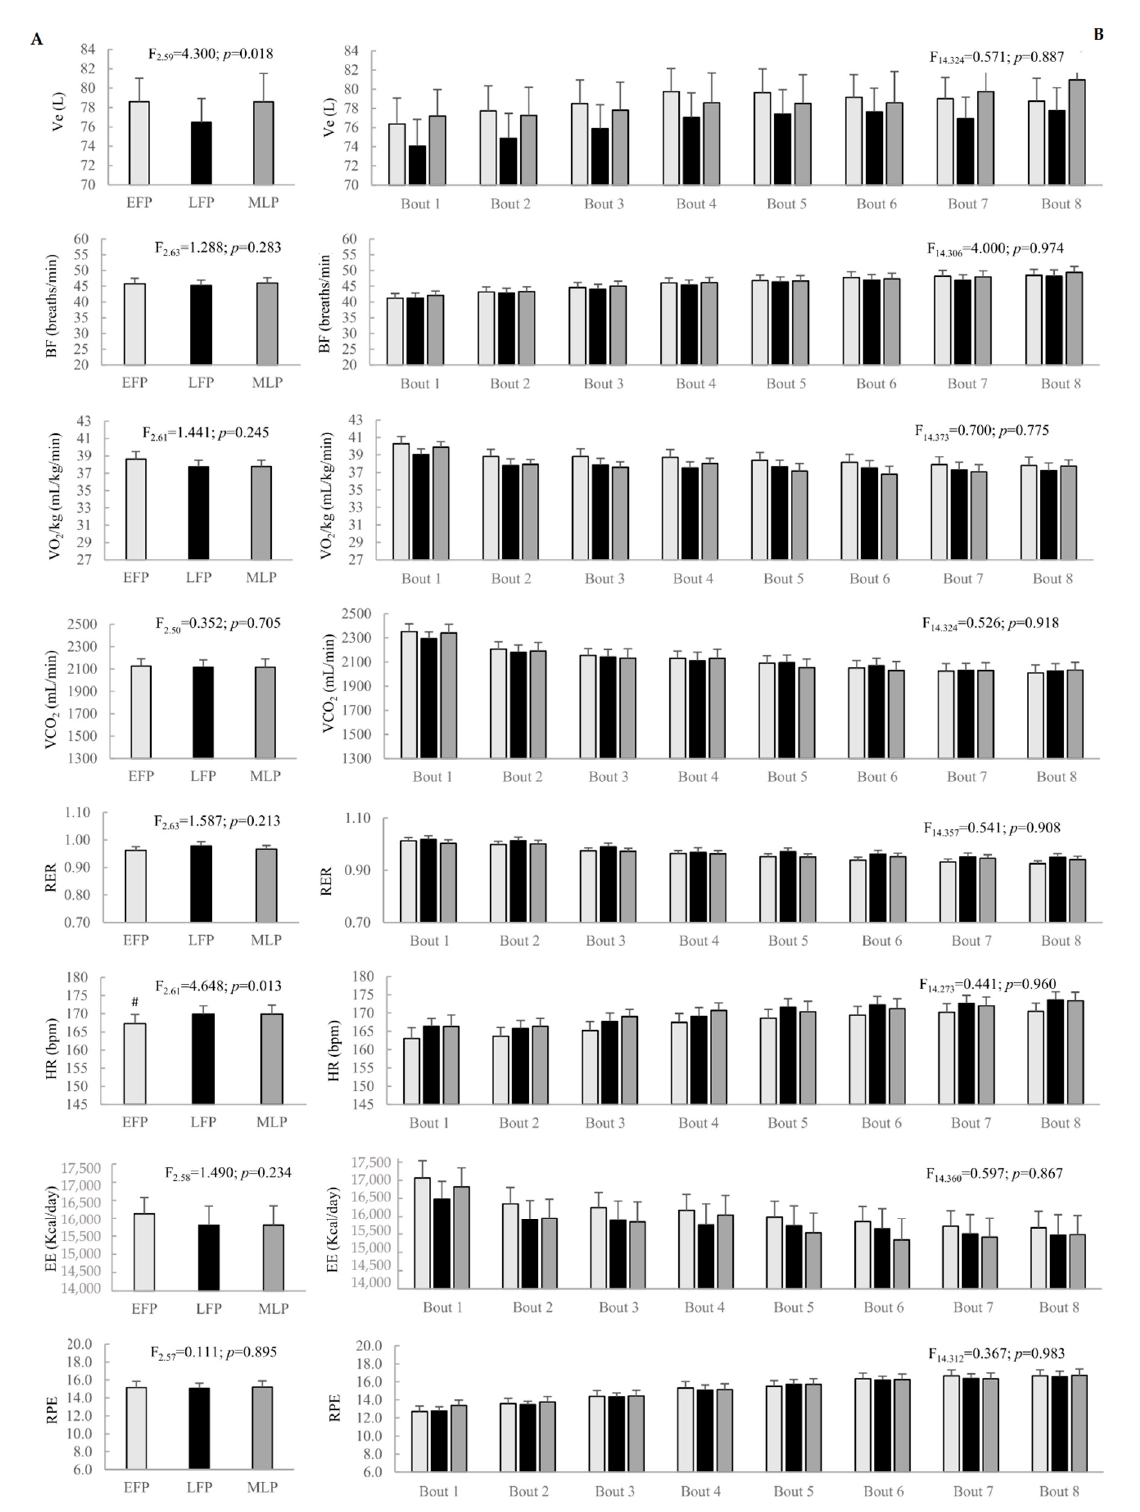
Figure 2. Menstrual cycle phase effect ( A ) and time* menstrual cycle interaction ( B ) on performance variables in the bouts throughout the interval running protocol. Ve: ventilation; BF: breathing frequency; VO 2 : oxygen consumption; VCO 2 : carbon dioxide production; RER: respiratory exchange ratio; HR: heart rate; EE: energy expenditure; RPE: rate of perceived exertion; EFP: early-follicular phase; LFP: late-follicular phase; MLP: mid-luteal phase. # Significant differences in LFP compared to EFP.